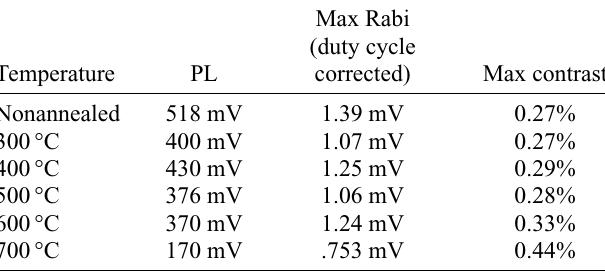
TABLE I. PL signal, max ODMR signal, and contrast of annealed